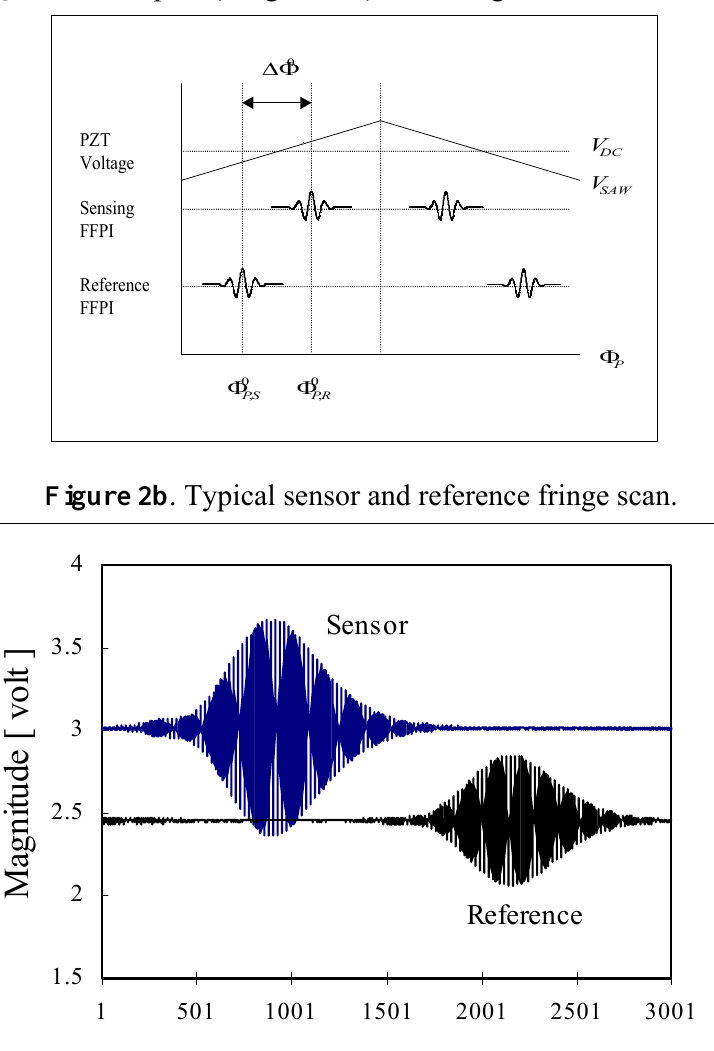
Figure 2a . Outputs (fringe scans) of sensing and reference FFPI.